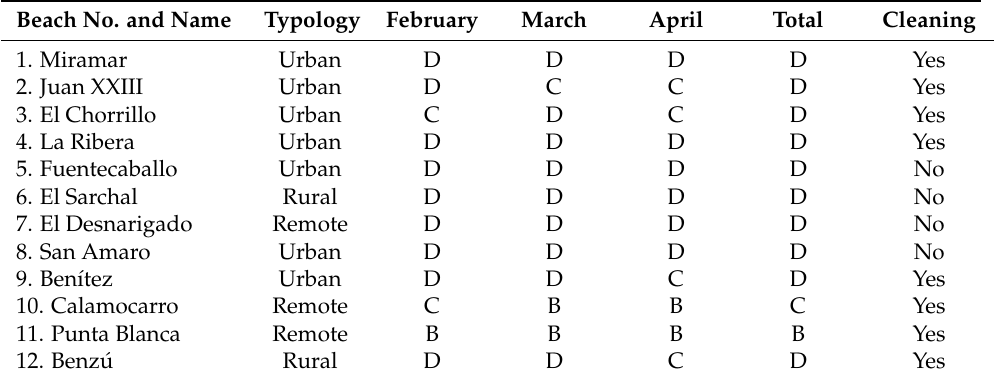
Table 6. Litter grade